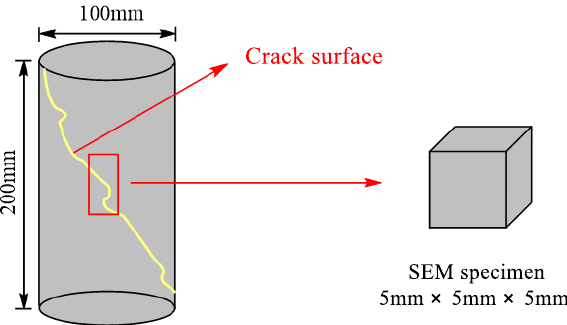
Figure 4. Schematic of the preparation of the specimen for SEM test.